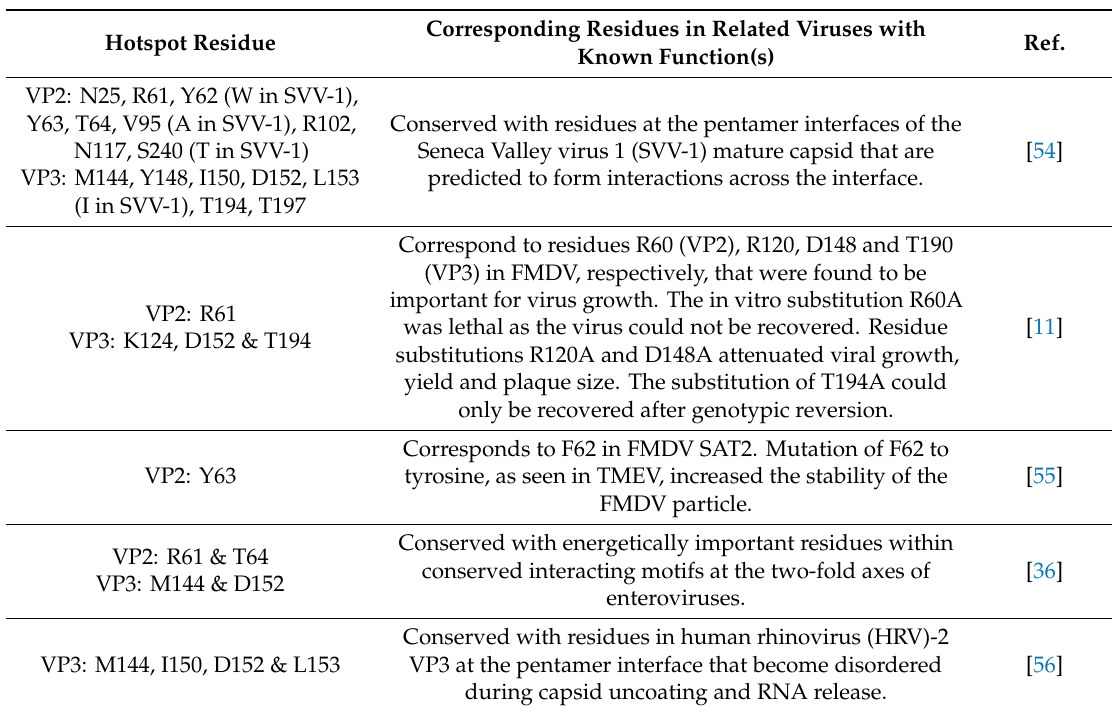
Table 7. Interpentamer hotspot residues in TMEV conserved with residues in related viruses with previously identified